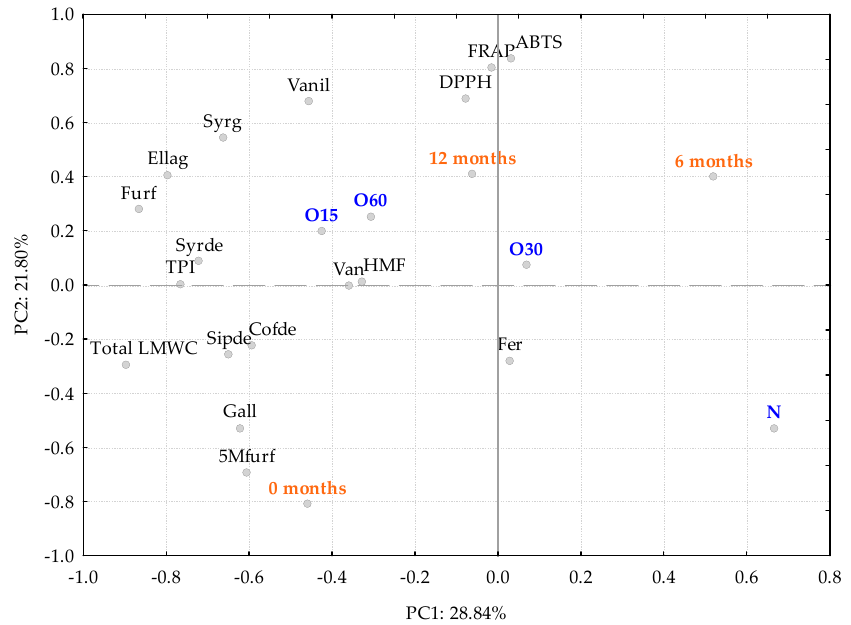
Figure 5. Principal Components Analysis (standardized scores and loadings)) with results of antioxidant activity, phenolic content (TPI) and individual LMW (Low molecular weight) compounds from aged WS using ageing modalities over time storage in the bottles. TPI—total phenolic index; Gall—gallic acid; Ellag—ellagic acid; Van—vanillic acid; Syrg—syringic acid; Fer—ferulic acid; Vanil—vanillin; Syrde—syringaldehyde; Cofde—coniferaldehyde; Sipde—sinapaldehyde; Furf—